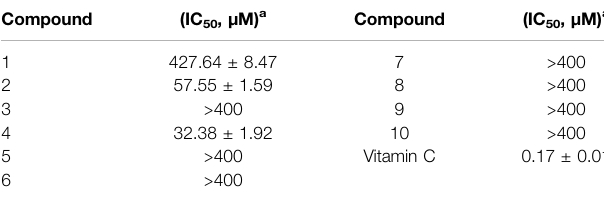
TABLE 2 | Ability of compounds 1 – 10 to scavenge DPPH